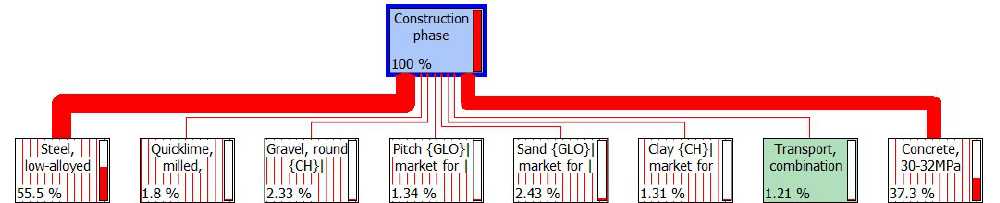
Figure 6. The environmental emissions network structure of fast track transportation project in construction phase. Note: Steel—the production of steel contributed to 55.5% of the environmental impact in the construction phase, Quicklime—the production of quicklime contributed to 1.8% of the environmental impact in the construction phase, Gravel—the production of gravel contributed to 2.33% of the environmental impact in the construction phase, Pitch—the production of pitch contributed to 1.34% of the environmental impact in the construction phase, Sand—the production of sand contributed to 2.43% of the environmental impact in the construction phase, Clay—the production of clay contributed to 1.31% of the environmental impact in the construction phase, Transport—the transportation of materials contributed to 1.21% of the environmental impact in the construction phase, Concrete—the production of concrete contributed to 37.3% of the environmental impact in the impact are not shown in this